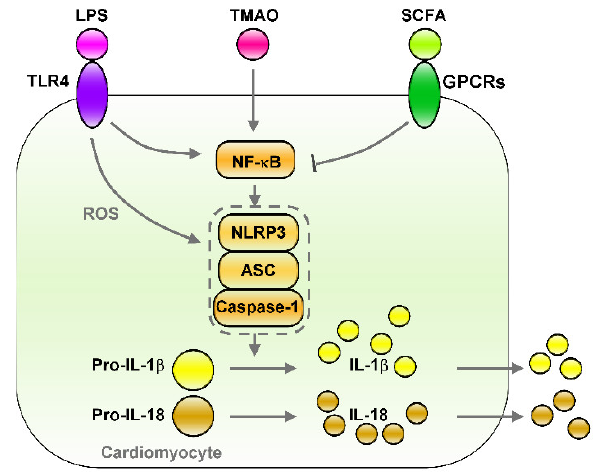
Figure 2. Effects of gut microbiota-derived endotoxin and metabolites on the regulation of NF- κ B/NLRP3 inflammasome signaling. Gut microbiota-derived endotoxin or metabolite signaling (such as LPS/TLR4, TMAO, and SCFA/GPCRs) that altered down-stream NF- κ B/NLRP3 inflammasome signaling and their effects on cardiac physiology. LPS/TLR4 and TMAO activates NF- κ B/NLRP3 axis and induces secretion of IL-1 β /IL-18. However, SCFA/GPCRs signaling inhibit NF- κ B/NLRP3 signaling. LPS: lipopolysaccharide, TLR4: toll-like receptor 4, TMAO: trimethylamine-N-oxide, SCFA: short-chain fatty acid, GPCRs: G-protein coupled receptors, ROS: Reactive oxygen species, NLRP3: NLR family pyrin domain containing 3, ASC: apoptosis-associated speck-like protein containing a caspase recruitment domain, Pro-IL-1 β : Pro-form interleukin 1 beta, Pro-IL-18: pro form interleukin 18, IL-1 β : interleukin 1 beta, IL-18: interleukin 18.